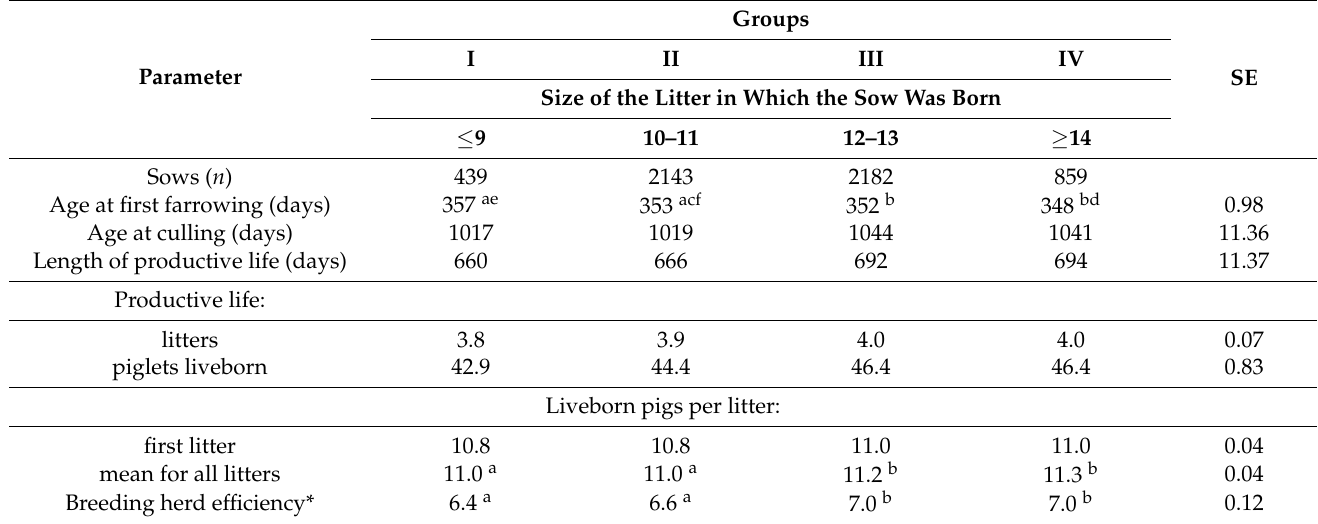
Table 3. Size of the litter in which the sow was born and her reproductive performance.